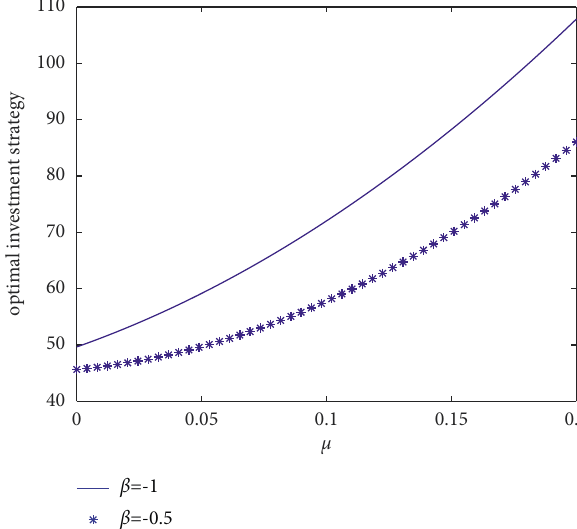
Figure 6: Influence of c on optimal investment ratio π ∗